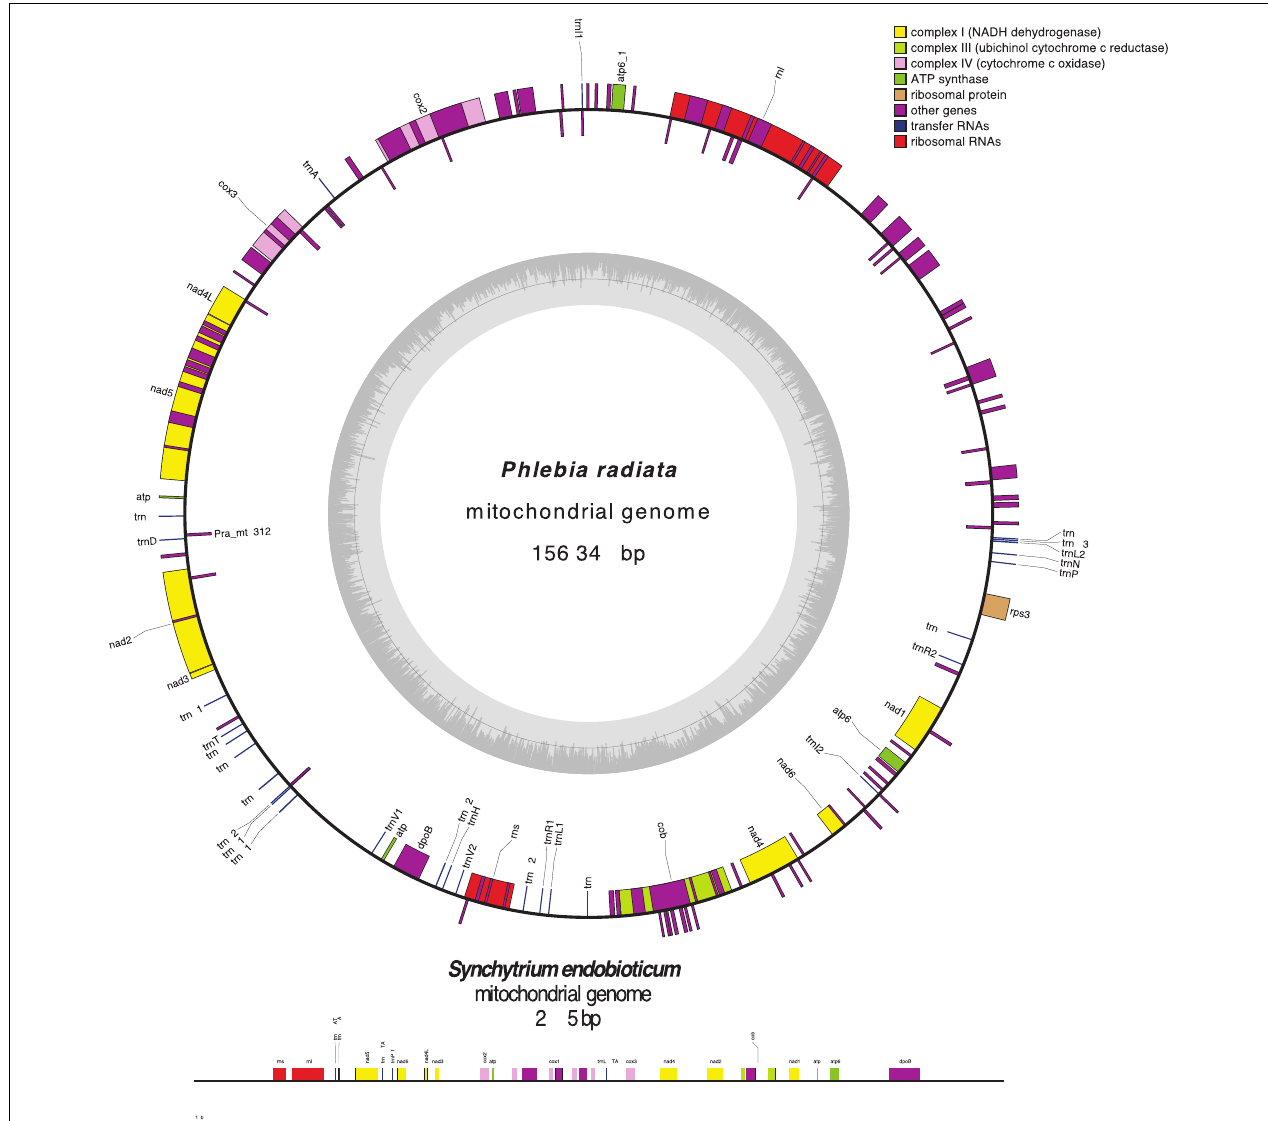
FIGURE 2 | Array and orientation of core genes, the untranslated genes of small and large ribosomal RNA subunits, and the AT/GC content of the circular mt-genome of Phlebia radiata (NC_020148, Basidiomycota) and the linear mt-genome of Synchytrium endobioticum (NC_042370, Chytridiomycota). Figure was made using OrganellarGenomeDRAW (OGDRAW) version 1.3.1 (Greiner et al.,